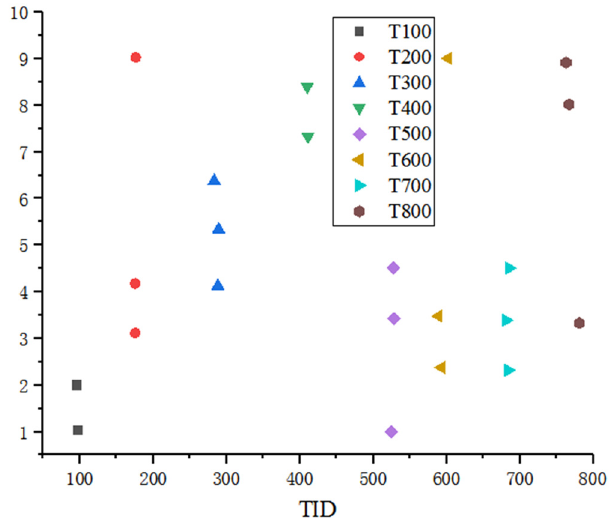
Figure 2: Set of related tuples of student course selection data.